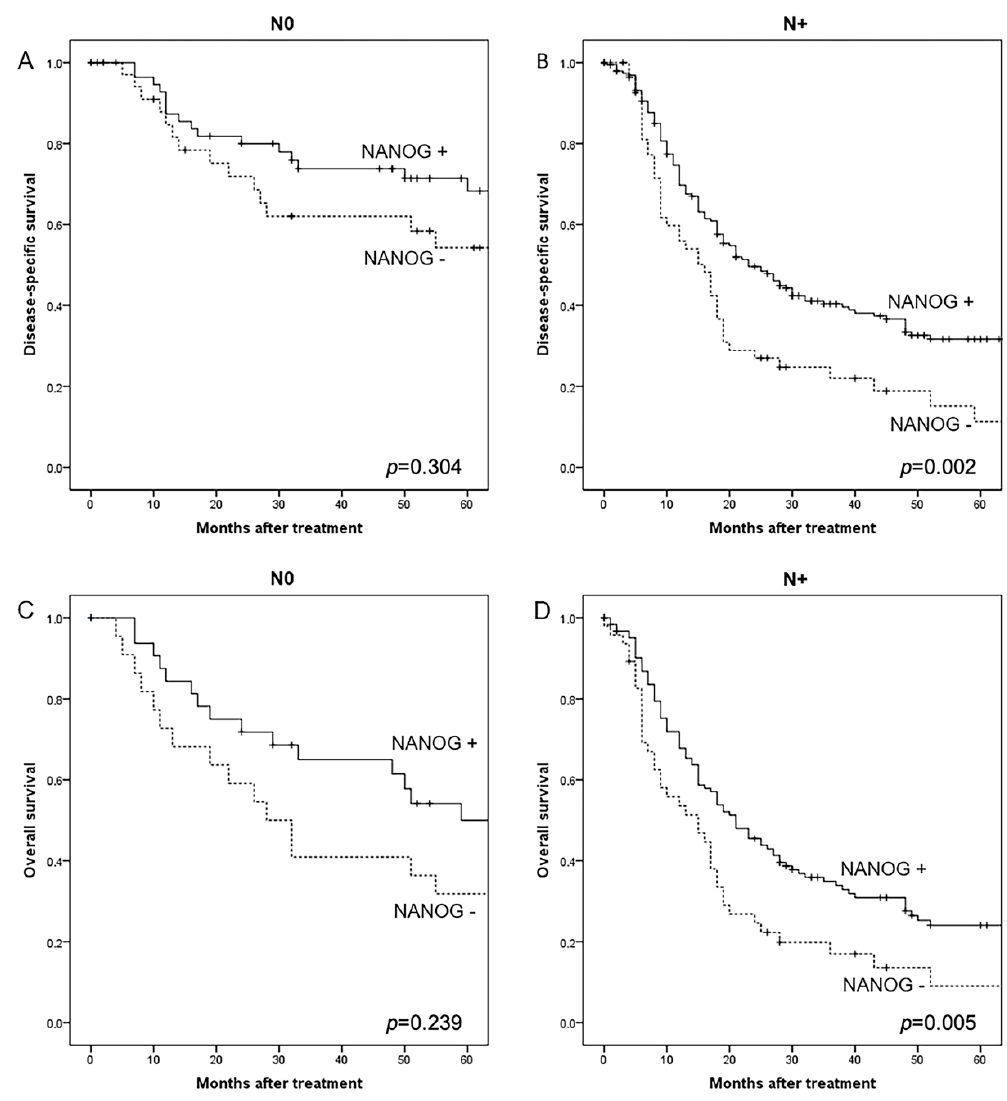
Figure 3. Kaplan–Meier disease-specific survival curves categorized by NANOG expression in N0 ( A ) and N + patients ( B ), and overall survival curves categorized by NANOG expression in N0 ( C ) and N + patients ( D